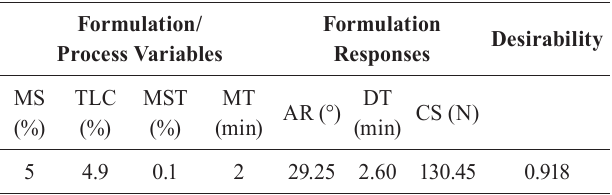
TABLE VII - Summary of results for Paracetamol tablets using optimum formulation and process variables